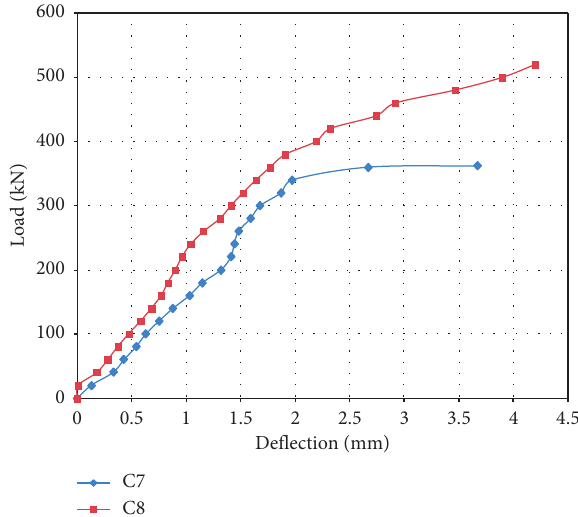
Figure 10: Load-deflection curve of corbels with 50% weight fractions of replacement aggregate for concrete strength 29.4 and 45.6MPa and a/d ratio 0.35.